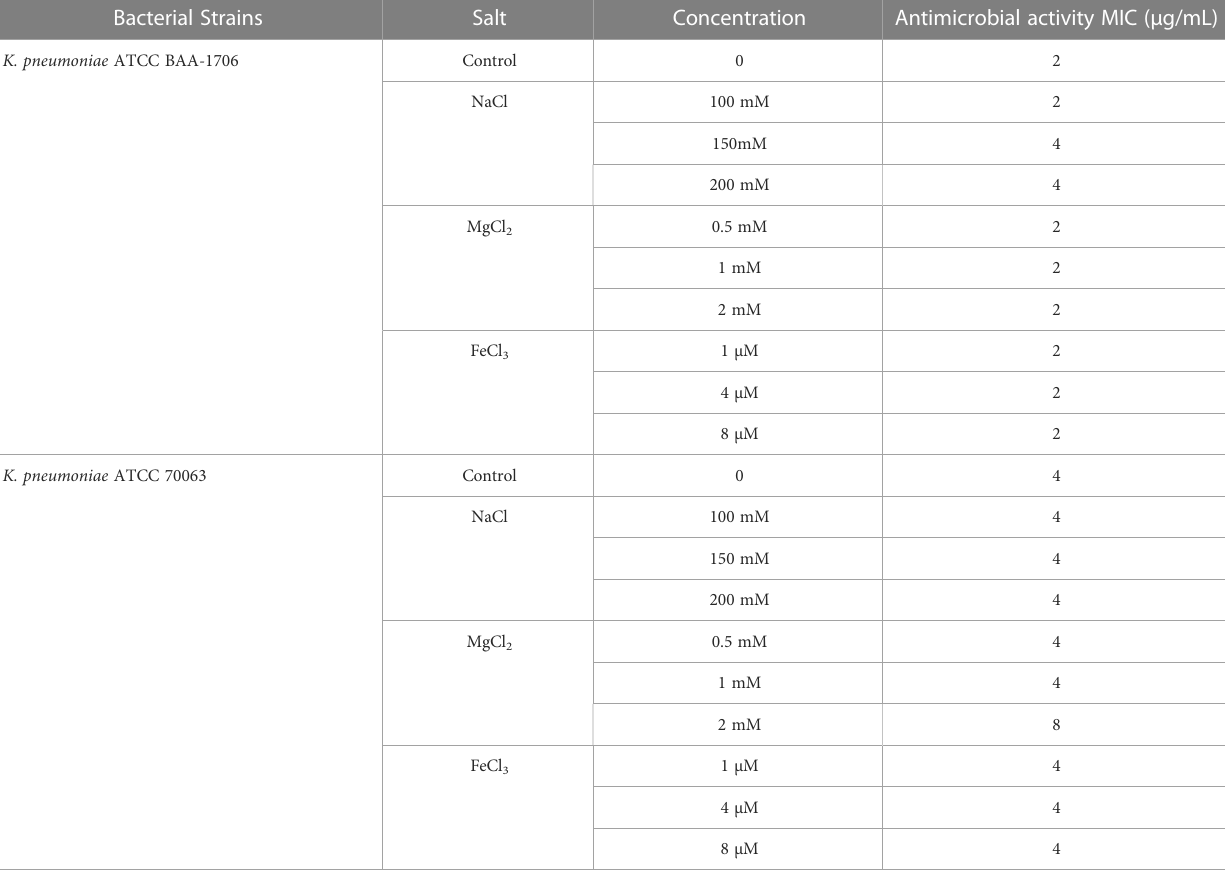
TABLE 5 The MIC values of the K11 against K. pneumoniae reference strains in the presence of physiological salts. Bacterial Strains